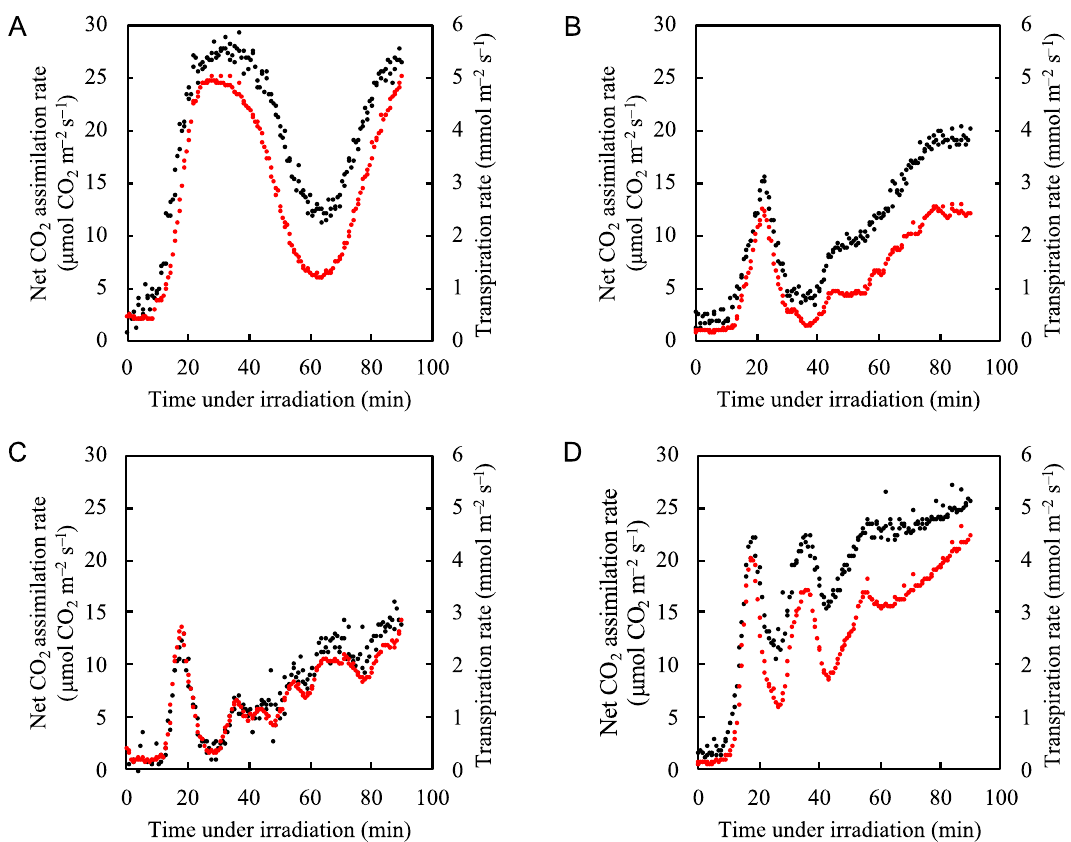
Figure 1. Fluctuation patterns of both the net CO 2 assimilation rate and transpiration rate under the steady-state actinic light illumination (700 µmol photons m –2 s –1 ) in rice leaves. Four examples are shown ( A–D ). The net CO 2 assimilation rate (black circles) and transpiration rate (red circles) were measured under 21 kPa O 2 /40 Pa CO 2 conditions. Actinic light was turned on at 0 min.